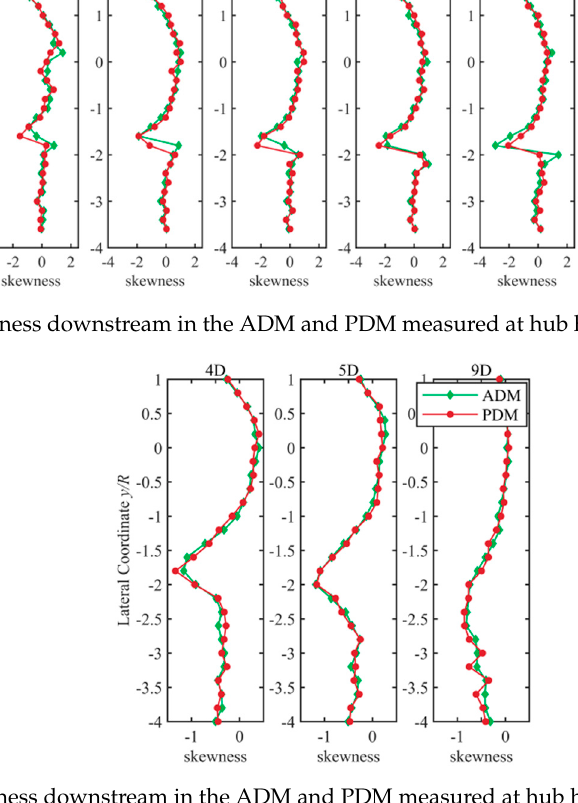
Figure 21. Skewness downstream in the ADM and PDM measured at hub height (ABL